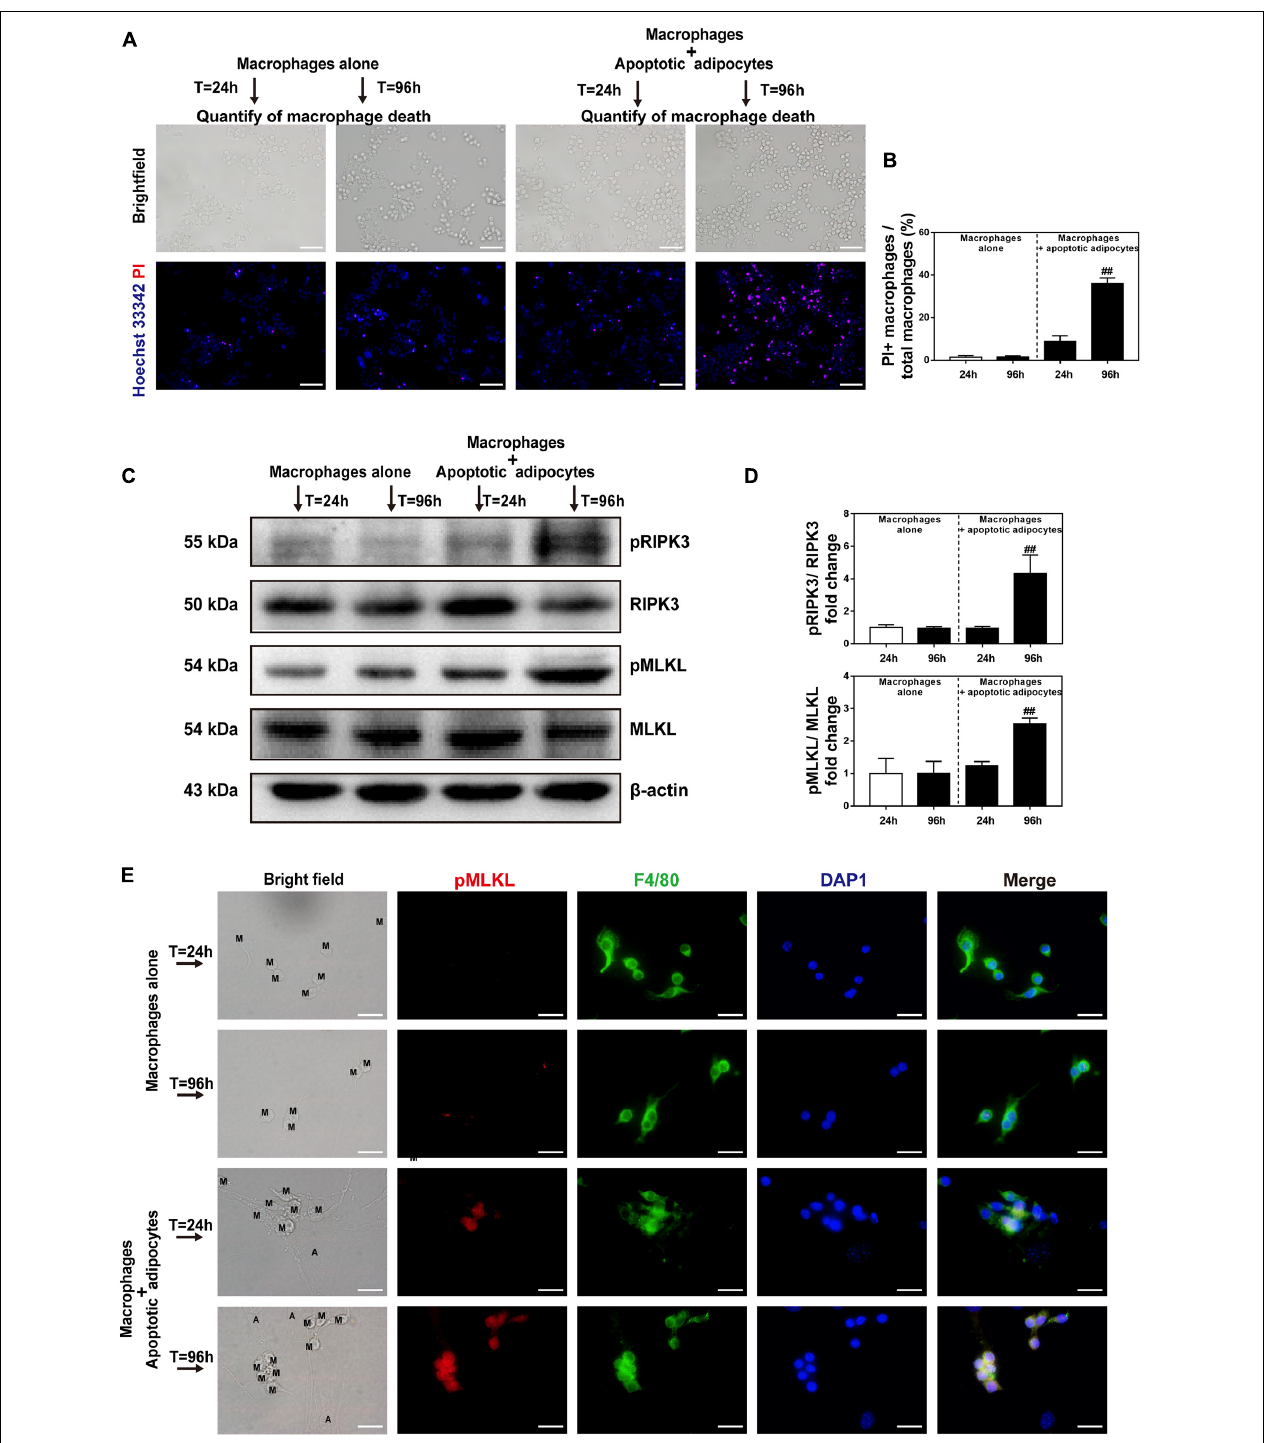
FIGURE 5 | Necroptosis is activated in MFCs in the in vitro CLS cell culture model. (A,B) Necrosis of macrophages determined by Hoechst 33342 and PI staining in the CLS cell culture group and in RAW 264.7 macrophages cultured alone at 24 and 96 h. (A) Hoechst 33342 + PI + macrophages in the pictures indicate necrotic macrophages. (B) Quantification of macrophage necrosis in both groups at 24 and 96 h. (C,D) Western blot analyses of MLKL, pMLKL, RIPK3, and pRIPK3 in the CLS cell culture group and in RAW 264.7 macrophages cultured alone at 24 and 96 h. (E) Immunofluorescence staining of pMLKL (red) and F4/80 (green) in the CLS cell culture group and in RAW 264.7 macrophages cultured alone at 24 and 96 h. Scale bars = 50 µ m. A, adipocyte; M, macrophage. Data are presented as the mean ± SD. ## P < 0.01 compared with the group of RAW 264.7 macrophages cultured alone at 24 h.